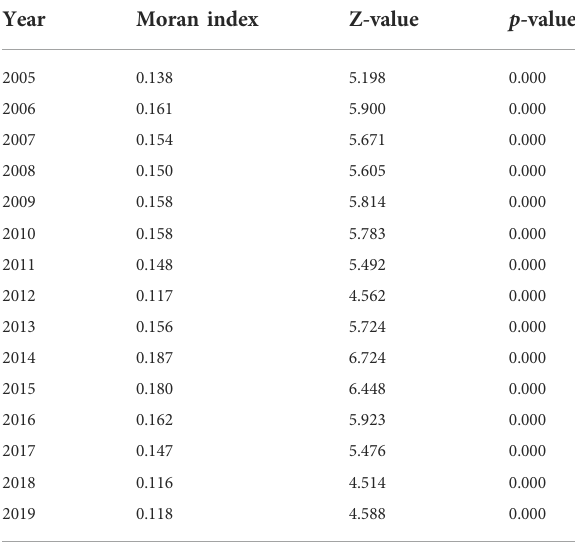
TABLE 3 Spatial Moran index of national atmospheric contamination from 2005 to